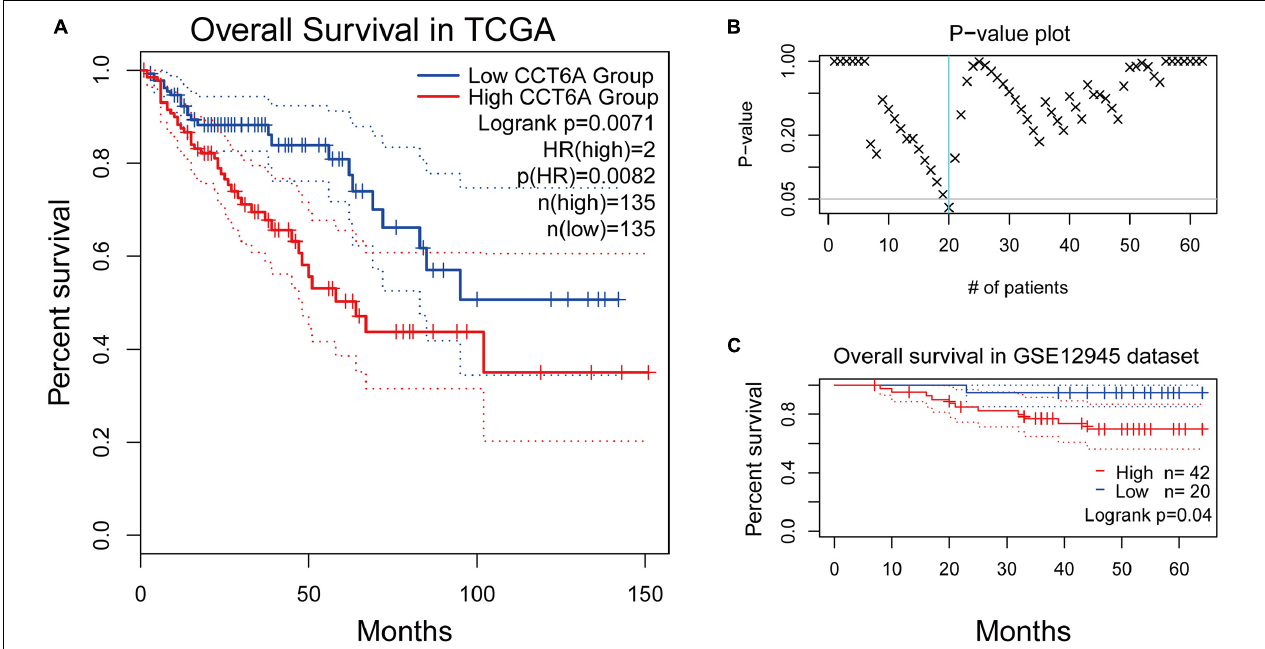
FIGURE 6 | Survival analysis of CCT6A in different datasets. (A) Kaplan-Meier survival curves comparing the high and low expression of CCT6A in different types of cancer using the GEPIA. (B) The p -value plot of survival analysis result by ProgScan. (C) Kaplan-Meier survival curves comparing the high and low expression of CCT6A in the GSE12945 dataset.